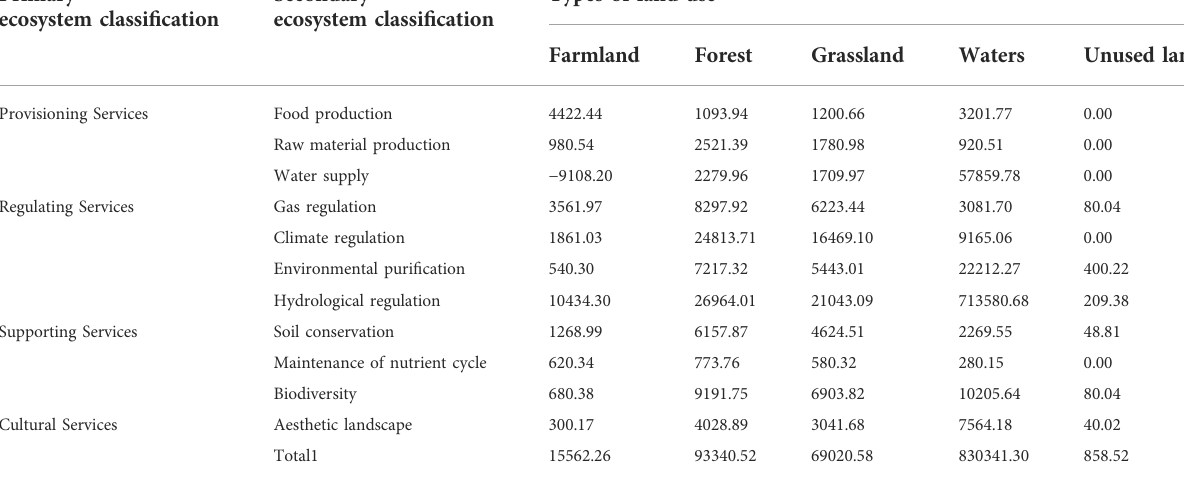
TABLE 2 Values for coef fi cients of various land ecosystem services in Jiangsu Province, China (yuan/hm 2 ). Primary ecosystem classi fi